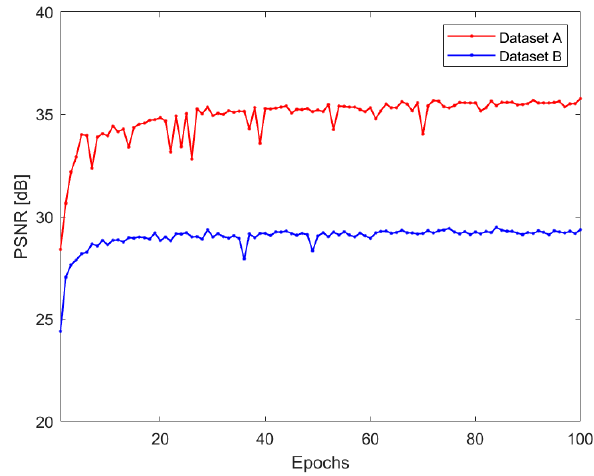
Figure 4. PSNR vs epochs of the SS-CNN model from the different datasets.